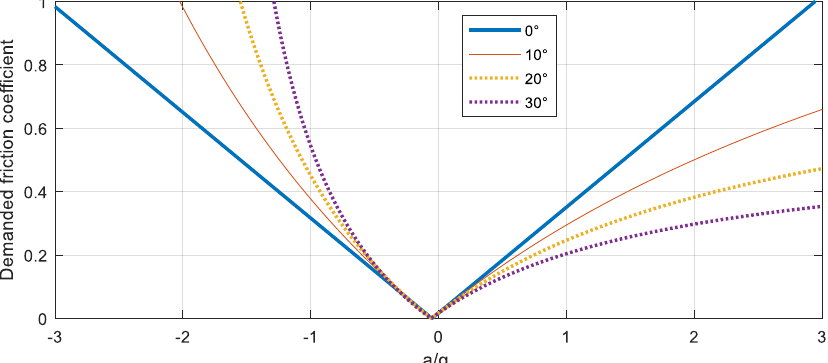
Figure 4. Friction coefficient needed to guarantee the pure rolling motion, 𝜃 = 3° , 𝑓 𝑣 = 0 , and parametric values of 𝜓 .